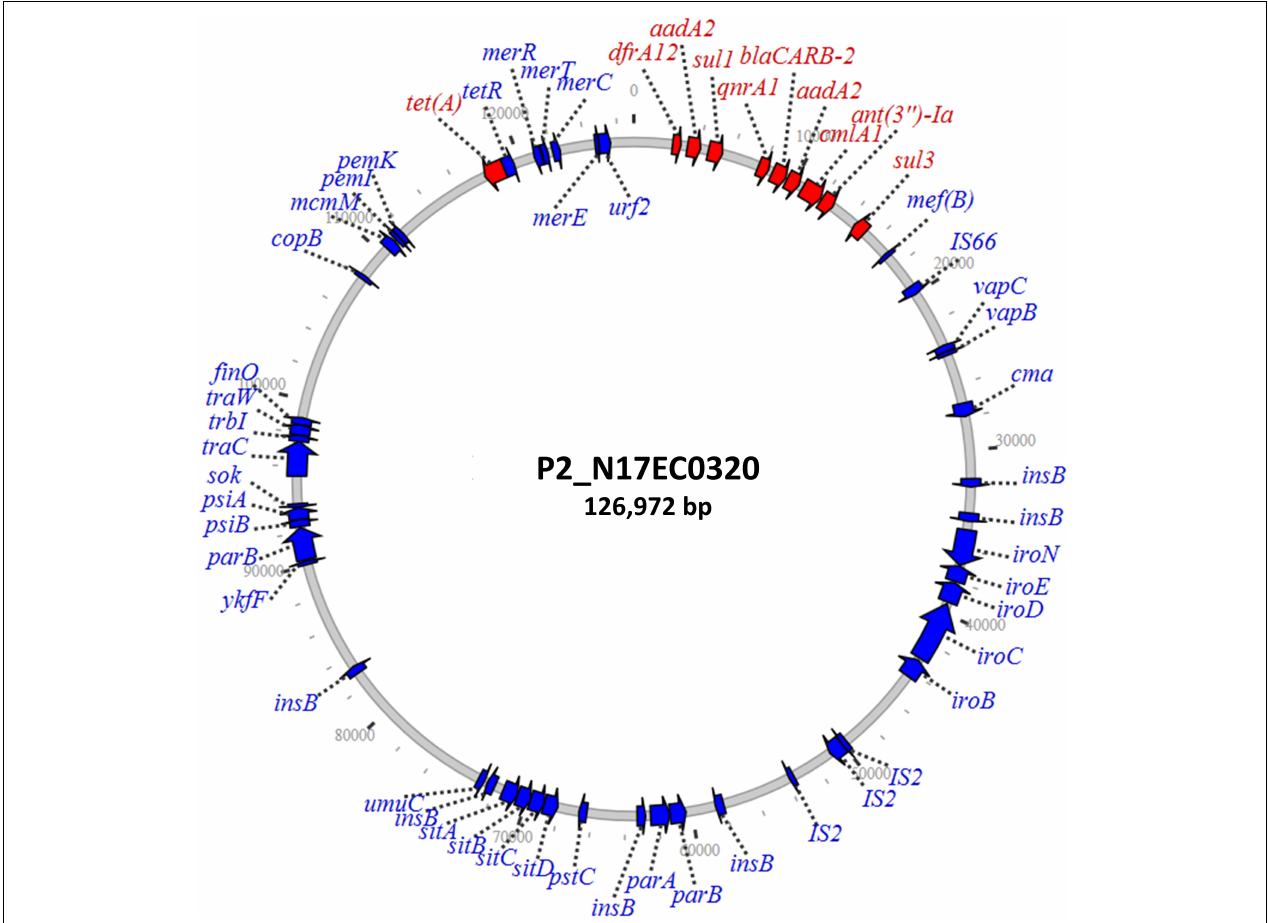
FIGURE 1 | IncF plasmid containing qnrA1 and other resistance genes. Resistance genes are depicted in red, with additional annotated genes depicted in blue.